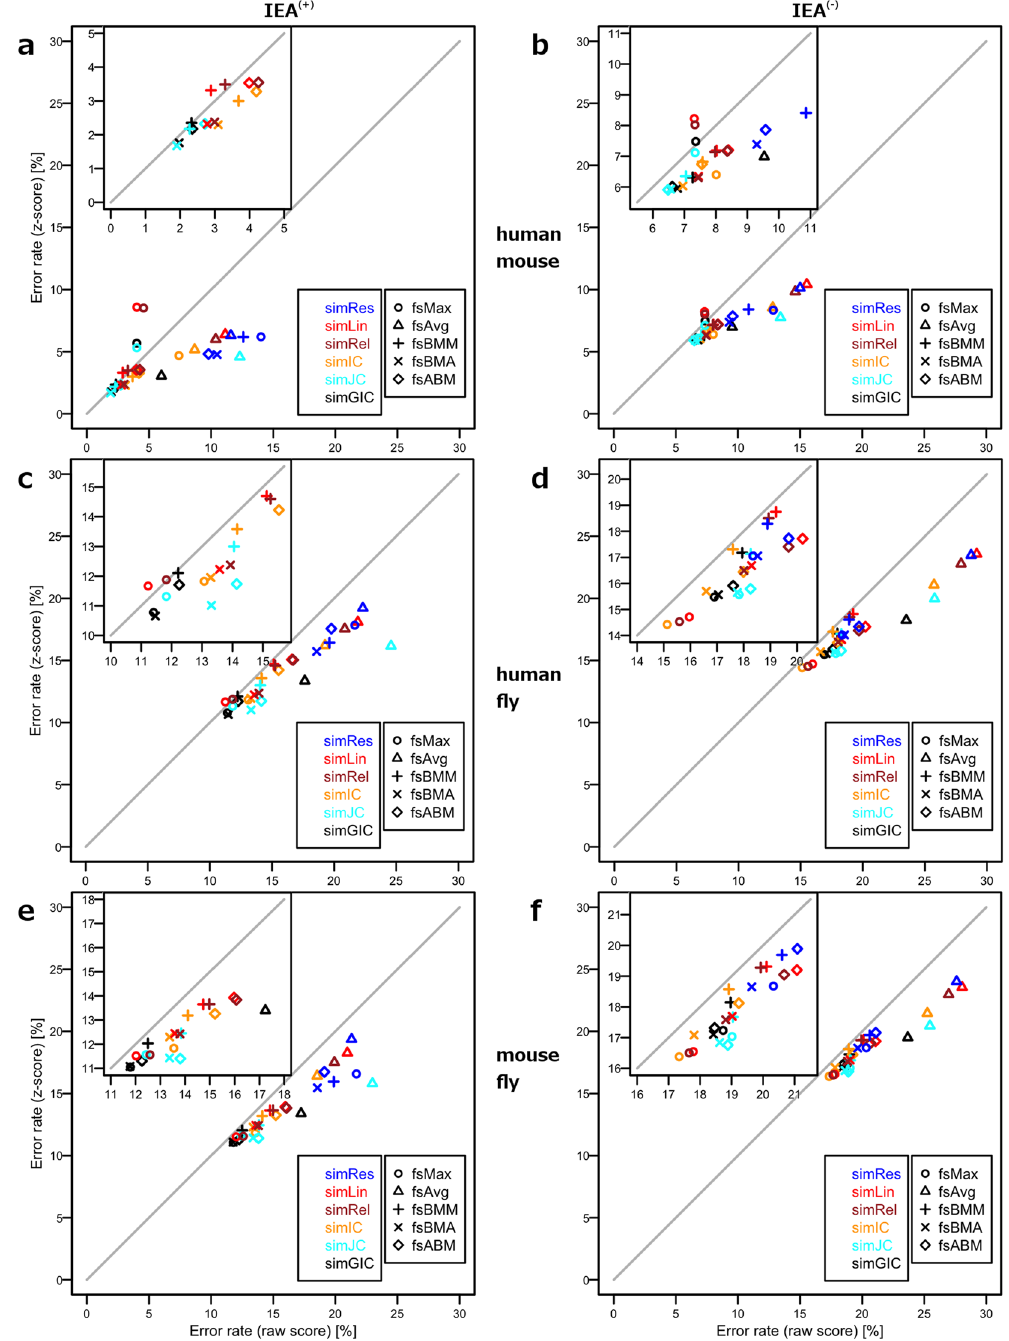
Figure 2. Error rate scatter plots comparing raw and z-scores for different FS scores in BP ontology. Each panel plots the error rates of raw scores ( x -axis) versus z-scores for pairs of orthologues and controls from selected organisms with a smaller inlay panel in the upper left corner focusing on the best scoring measures. The thick grey diagonal line serves as a measure performance indicator, as any point on this line corresponds to a measure that achieves exactly the same error rate with raw and with z-scores. Any deviation from this line therefore indicates an error rate improvement by either using the raw scores or the z-scores. The first column (panels a,c, and e) presents results from an annotation corpus including electronic annotations, whereas the second column shows the outcome where electronic annotations have been excluded. The rows correspond to the organism pairs used for scoring by orthology: first row, human/mouse; second row, human/fly; third row, mouse/fly. A legend present in each lower right corner gives rise to the colour encoding of SS measures and symbols coding for mixing